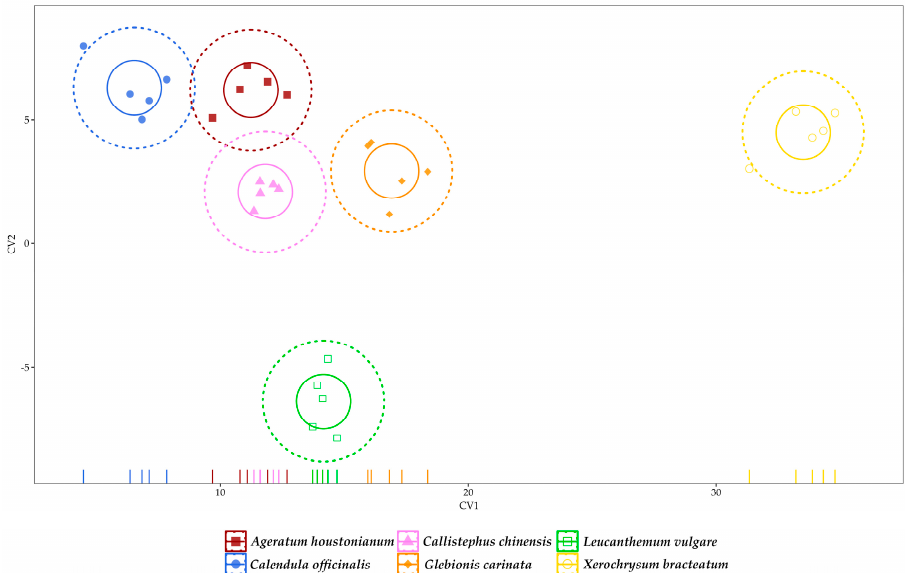
Figure 7. CVAcon biplot. Different colours and shapes distinguish individuals from different group species. The solid inner circles represent the 95% tolerance region for the population mean; the outer dotted circles represent the 95% confidence region of the group means. The coloured rugs above the x -axis represent the projection of the individuals belonging to each group.